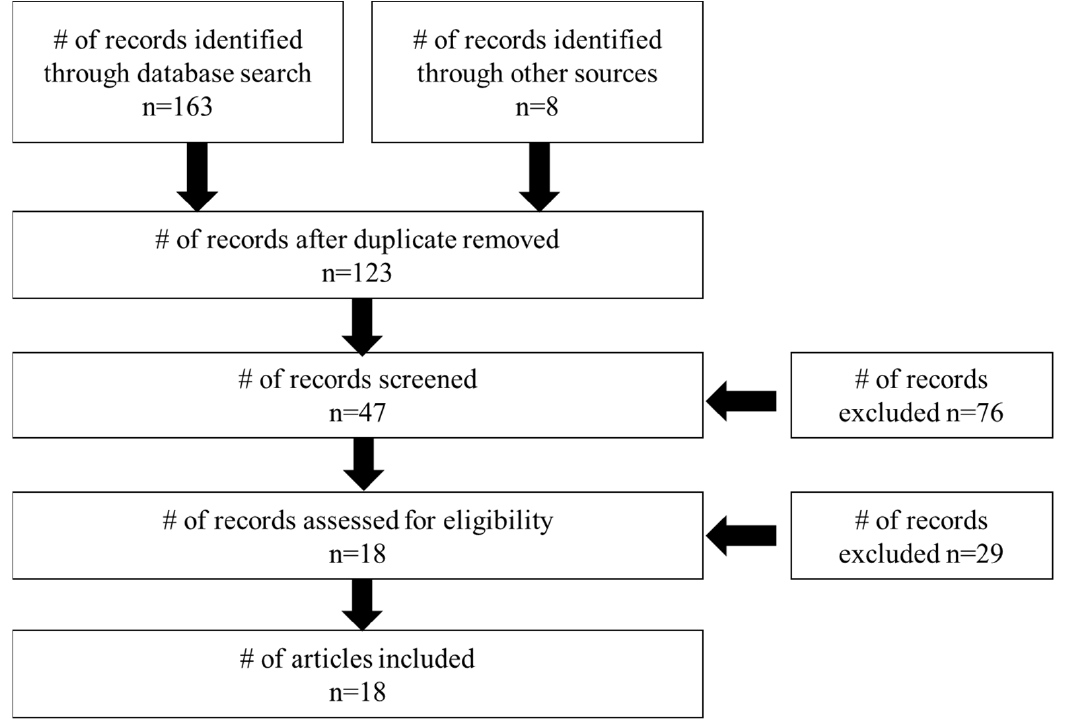
Figure 1. The process of the literature review based on Page et al. (2021).